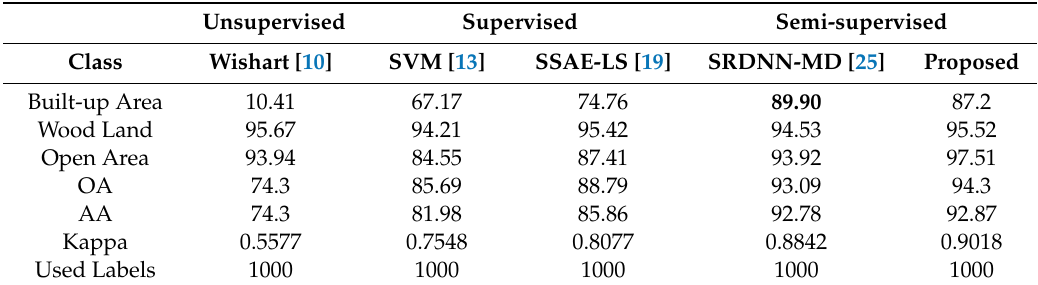
Table 4. Classification accuracy (%) comparisons on Oberpfa ff